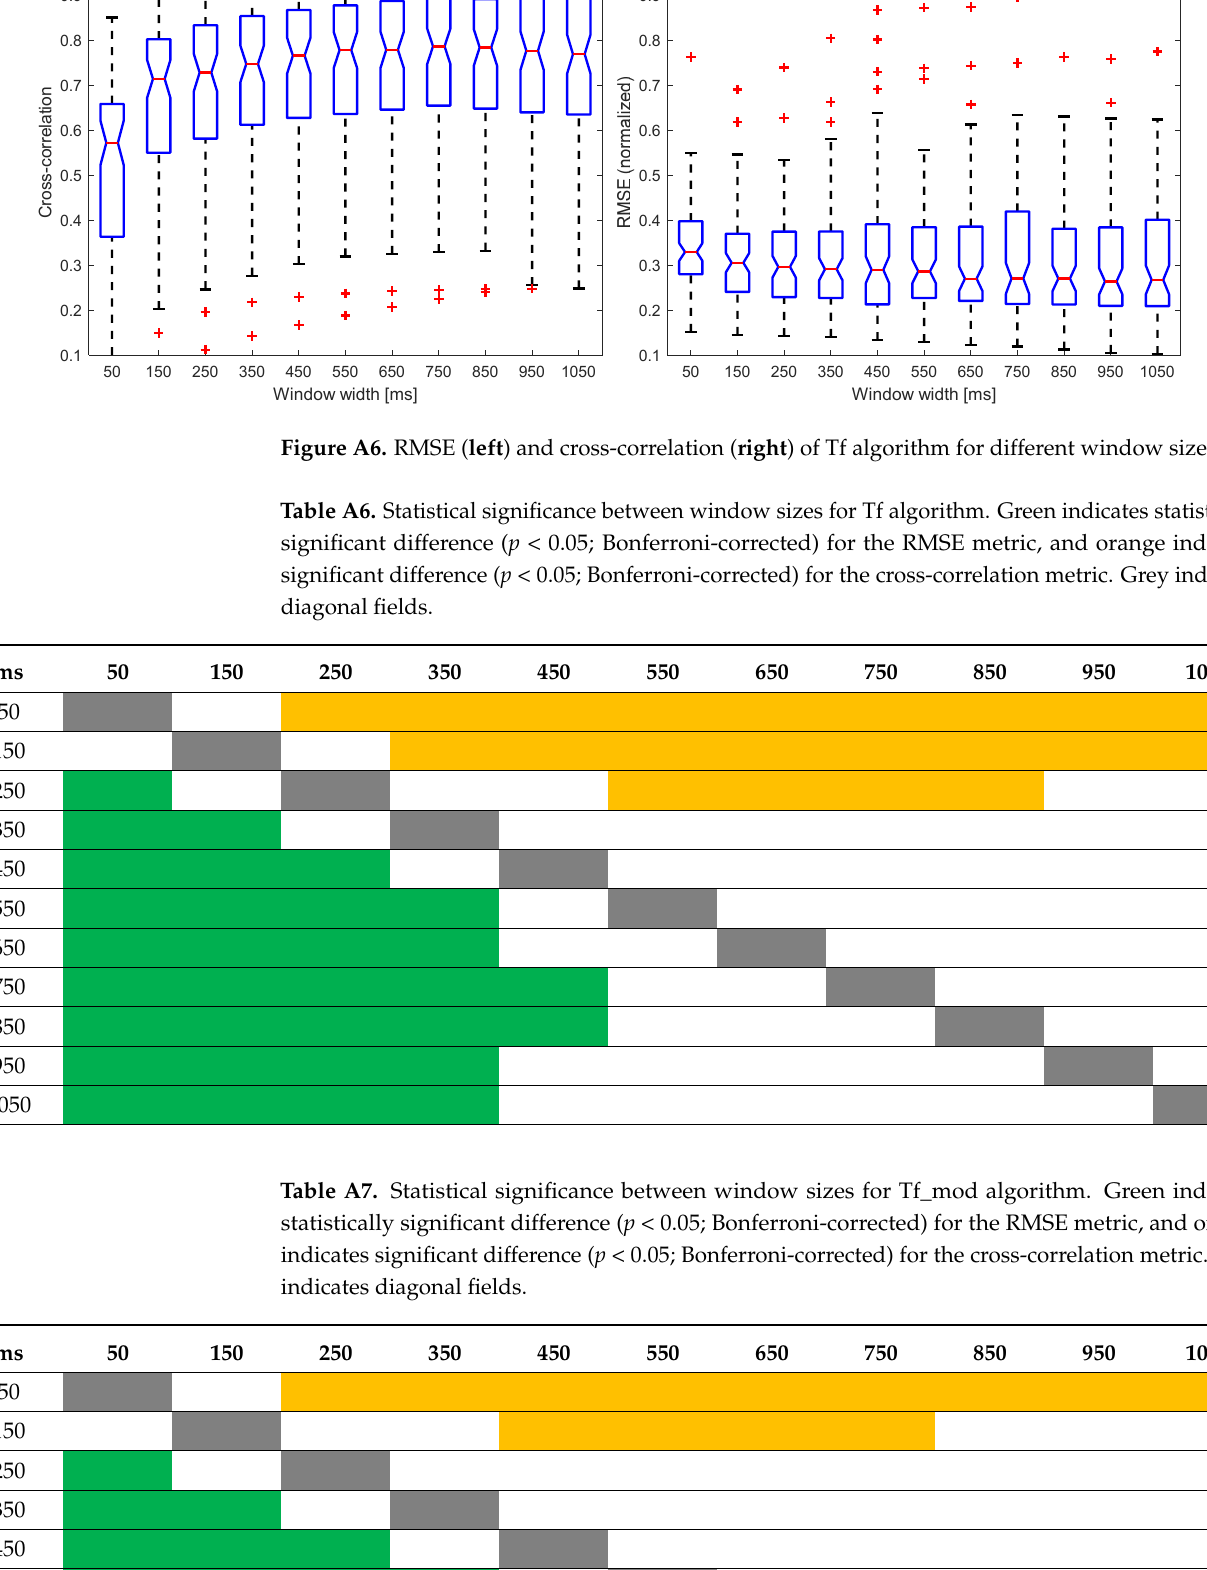
22 of 28 Figure A5. RMSE ( left ) and cross-correlation ( right ) of Ttd algorithm for different window sizes. Table A5. Statistical significance between window sizes for Ttd algorithm. Green indicates statisti- cally significant difference ( p < 0.05; Bonferroni-corrected) for the RMSE metric, and orange indicates significant difference ( p < 0.05; Bonferroni-corrected) for the cross-correlation metric. Grey indicates diagonal fields. ms